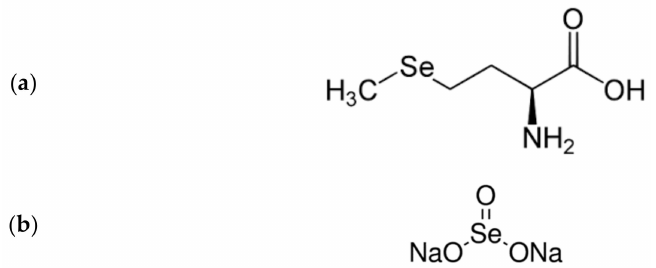
Figure 3. Molecular formulae of ( a ) selenomethionine and ( b ) sodium